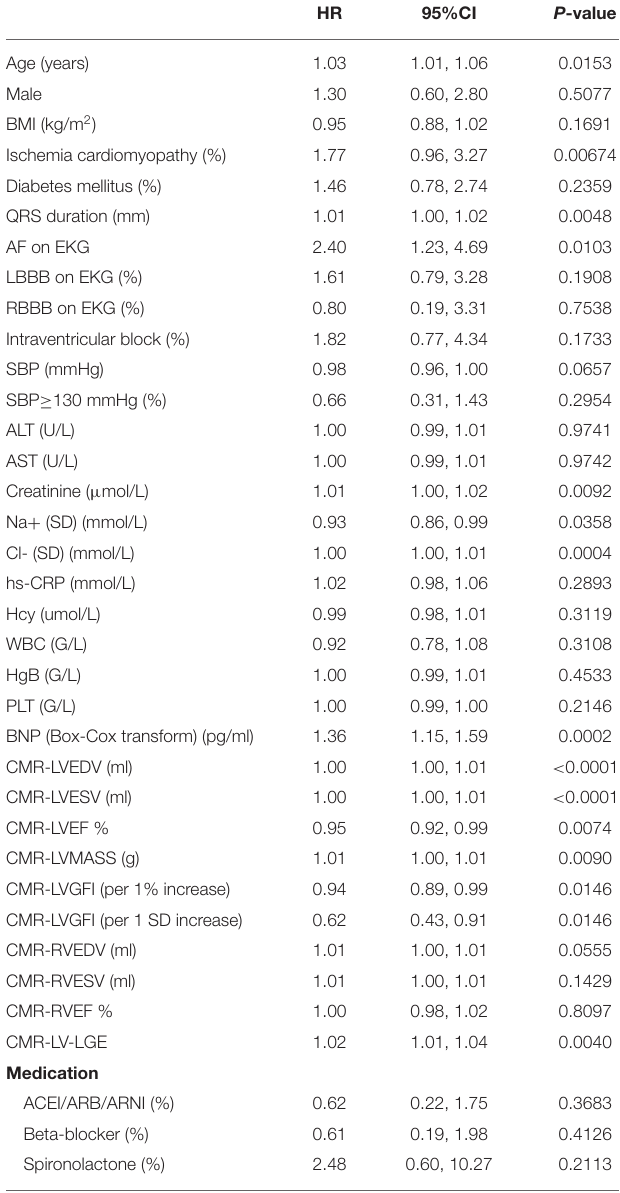
TABLE 2 | Univariate Cox analysis for MACEs in patients with HF within the median follow-up period of 565